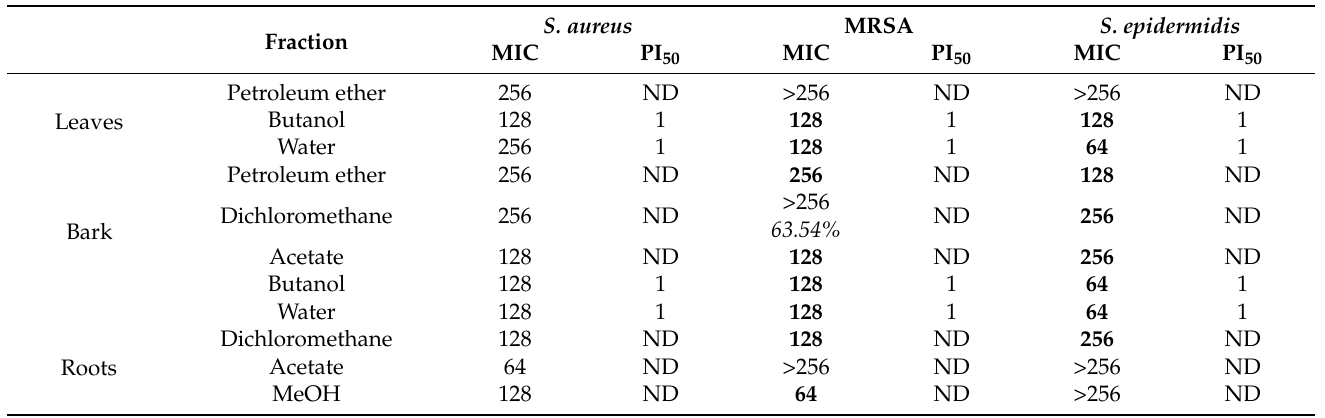
Table 3. Antibacterial activities (i.e., MIC in µ g/mL) of the most effective fractions on different strains of Staphylococcus